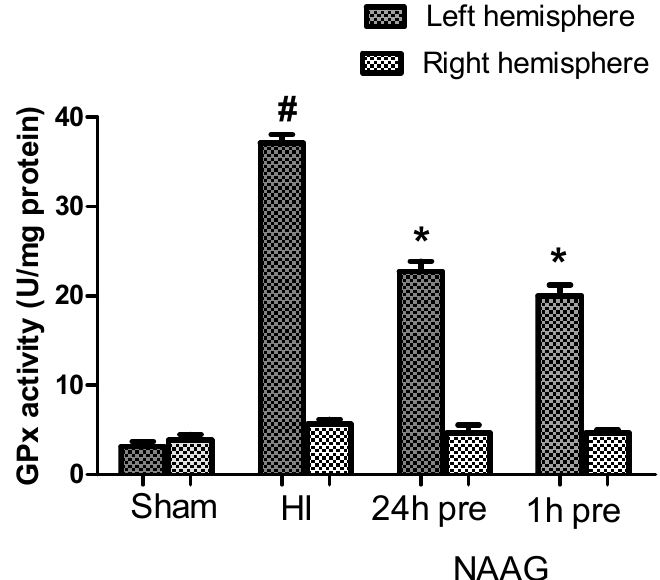
Figure 5. Effect of NAAG application on changes in glutathione peroxidase activity induced by HI. The results are presented as the means ± SEM, n = 6–7; statistically significant differences: * p < 0.001 compared to the HI group; # p < 0.001 compared to the sham operated group.